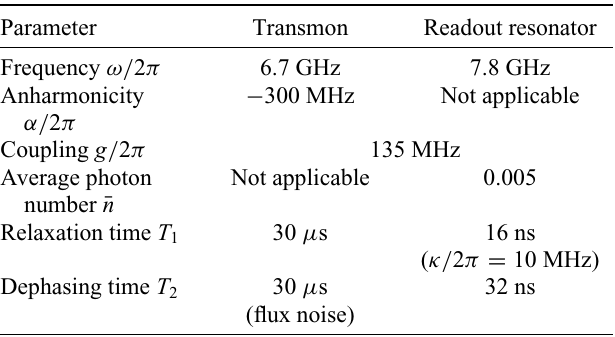
TABLE I. Parameters used both in the analysis and Lindblad simulations of the readout-resonator LRU, similar to the exper- imental ones in Ref. [27]. The transmon parameters correspond to the target parameters of a high-frequency data qubit in Sec.